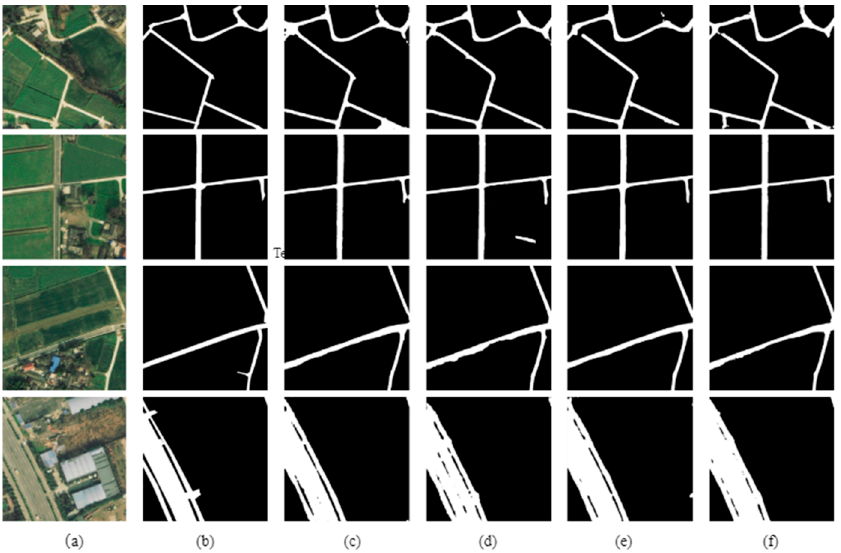
Figure 9. Results in the simple scenes: ( a ) original images; ( b ) labels; ( c ) D-LinkNet (101); ( d ) DenseNet (k = 24) + initial block; ( e ) DenseNet (k = 24) + stemblock; ( f ) D-DenseNet (k = 24) + stem block.